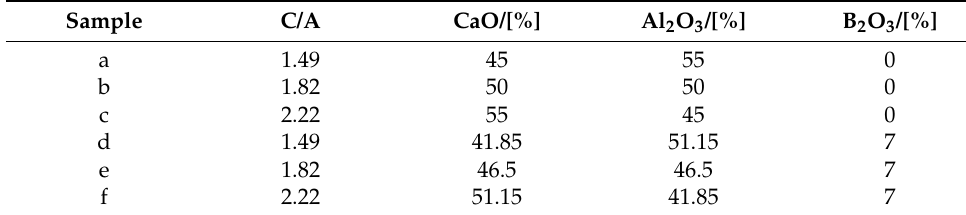
Table 3. Compositions of the viscosity measurement samples (wt pct) with different CaO/Al 2 O 3 mole ratios.